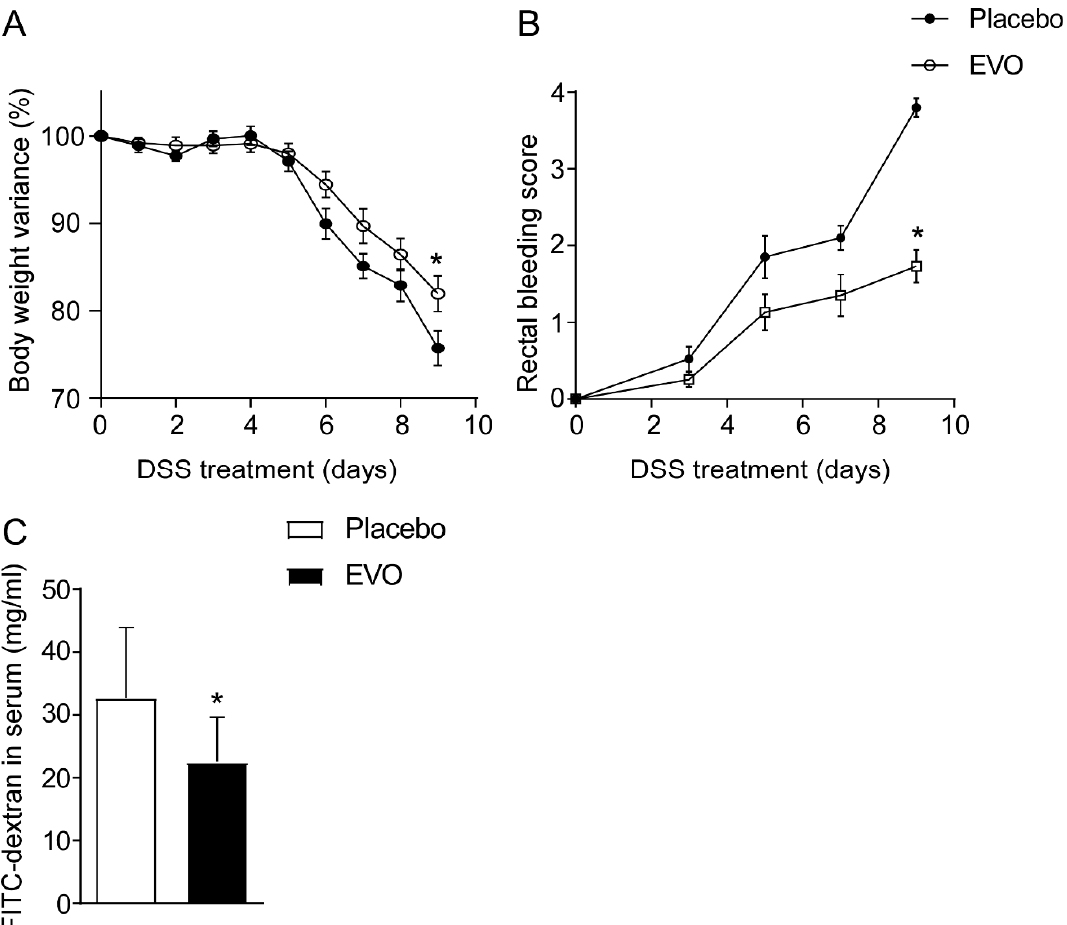
Figure 1. EVO administration confers protection against dextrane sodium sulfate (DSS)-induced colitis. ( A ) Percentage of body weight variance during DSS treatment, ( B ) visible rectal bleeding score, ( C ) in vivo intestinal permeability measurement after DSS-induced intestinal inflammation in C57Bl/J6 mice. All values represent means ± SD. Statistical significance comparing EVO versus Placebo (* p < 0.05) assessed by Mann–Whitney’s U test.